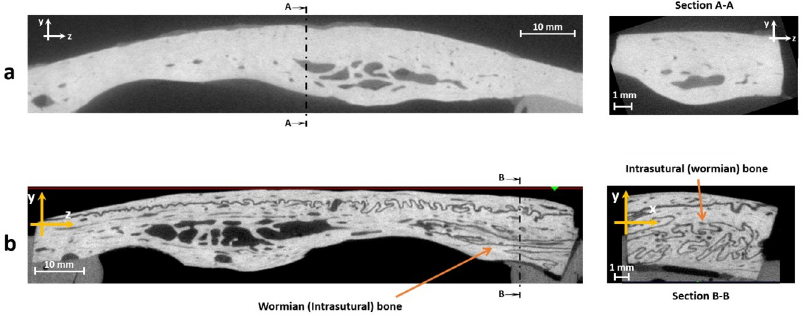
Fig 4. microCT scans of equine parietal bone. a) Lateral view (left) and cross-section (right) of a specimen without Wormian bone, b) Lateral view (left) and cross-section (right) of a sample with Wormian